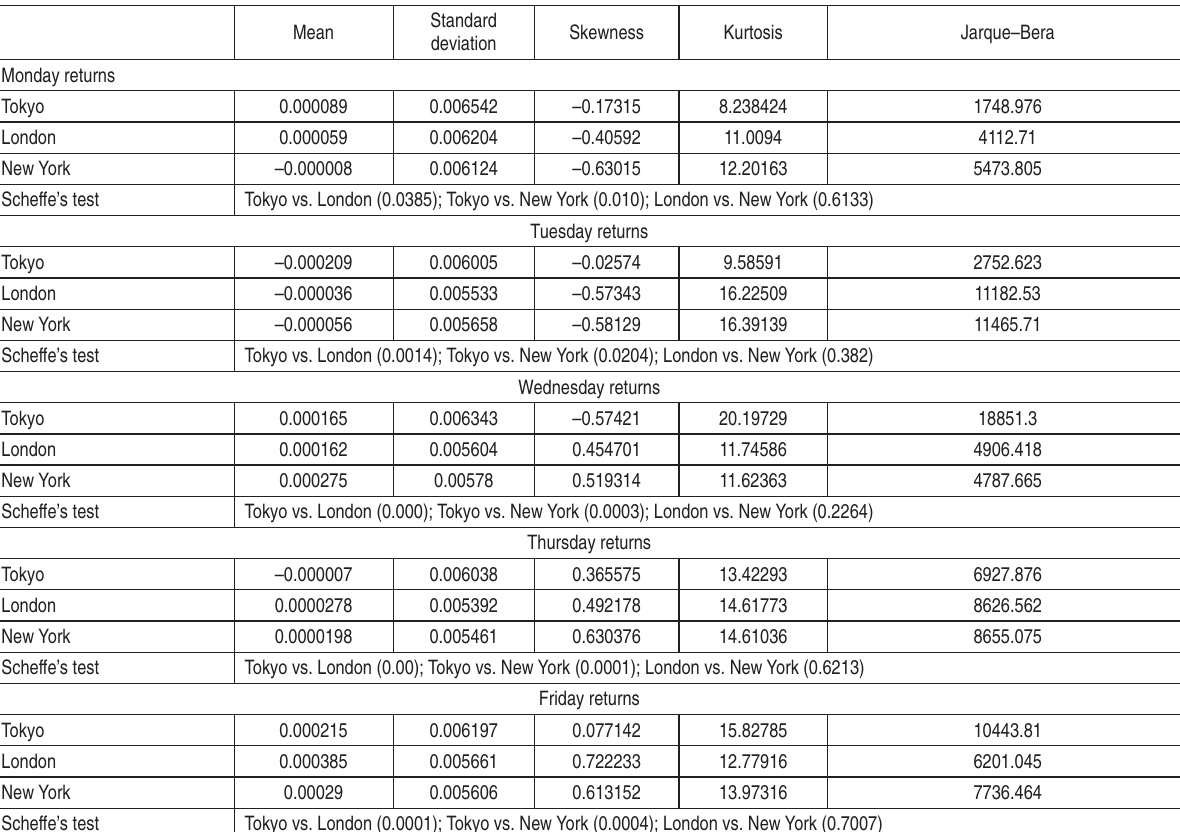
Table 3. Summary statistics of panel intraday returns from Monday to Friday in Tokyo, London and New